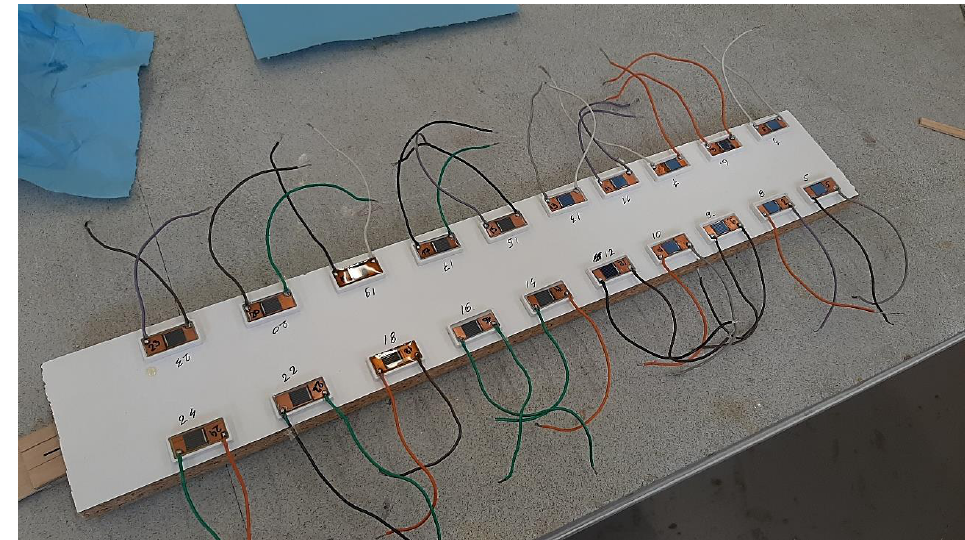
Figure 3. Molds for ensuring the uniformity of coating and the cells